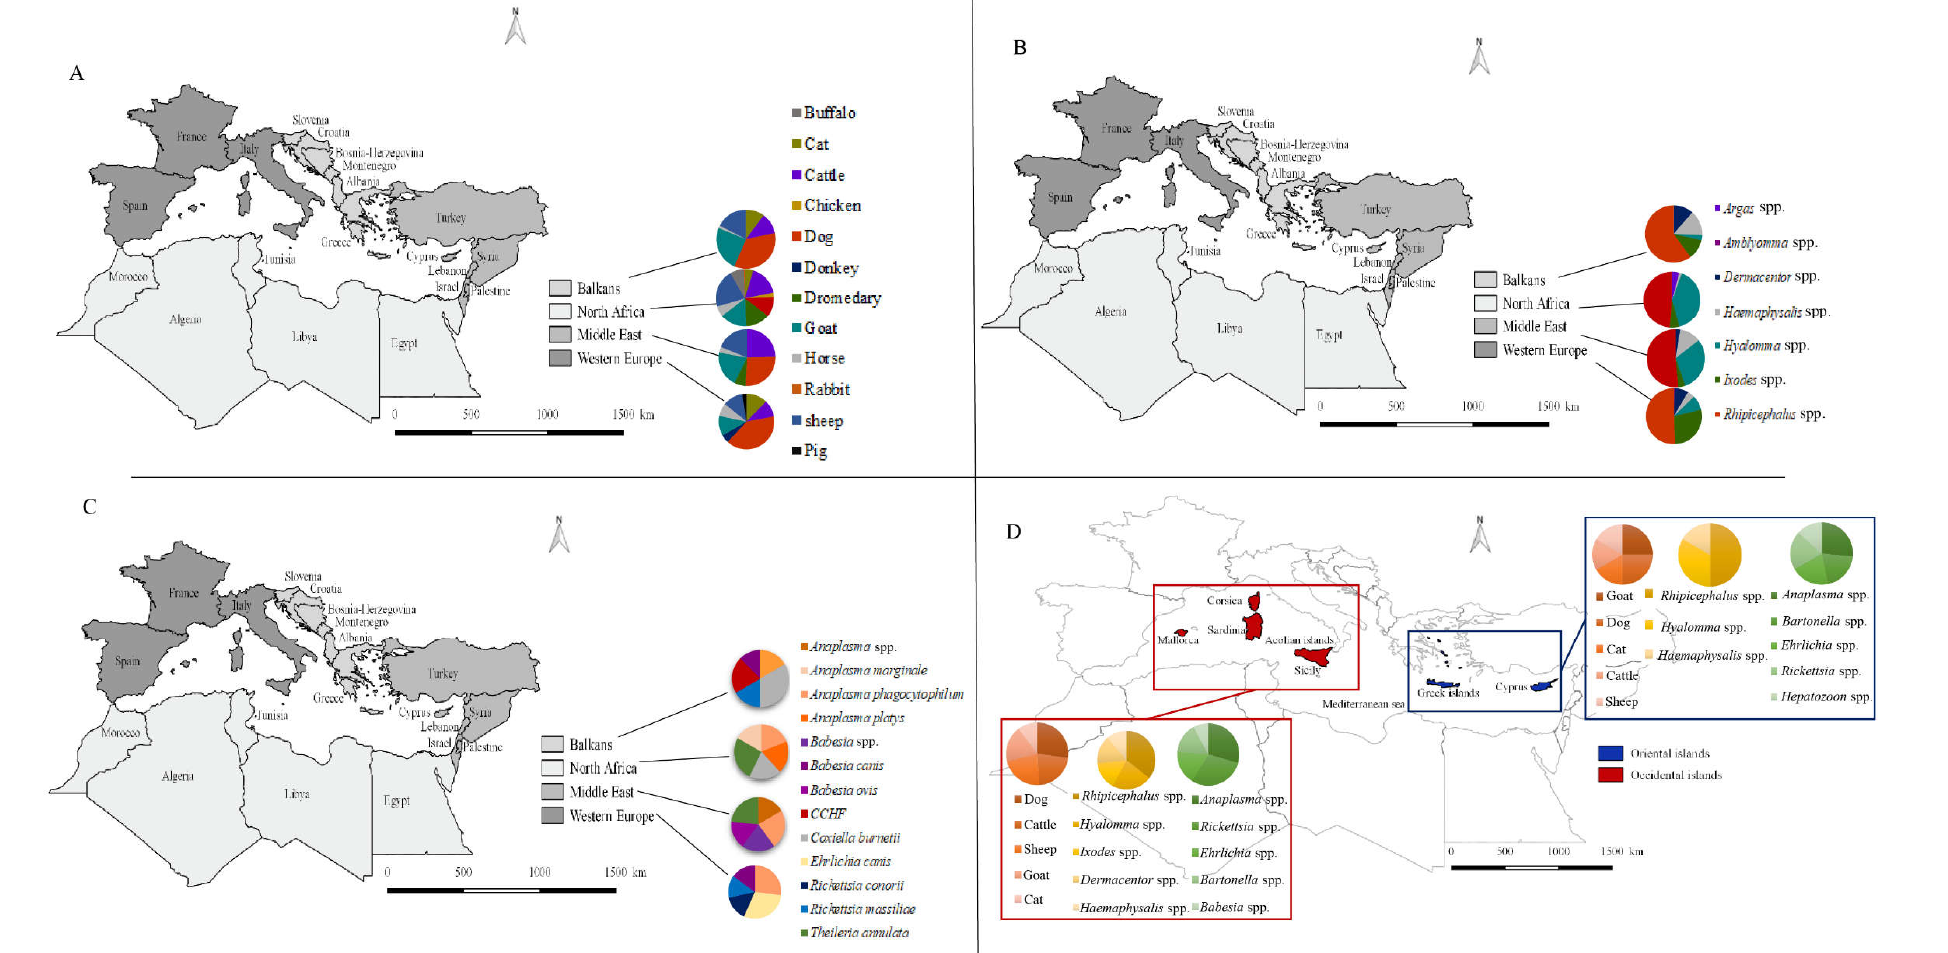
Figure 6. Map of the main domestic animal hosts ( A ), main positive tick genera ( B ), main TBPs in the four areas of the Mediterranean Basin ( C ), and main domestic animal hosts, positive tick genera and TBP genera in the western and eastern islands ( D ).